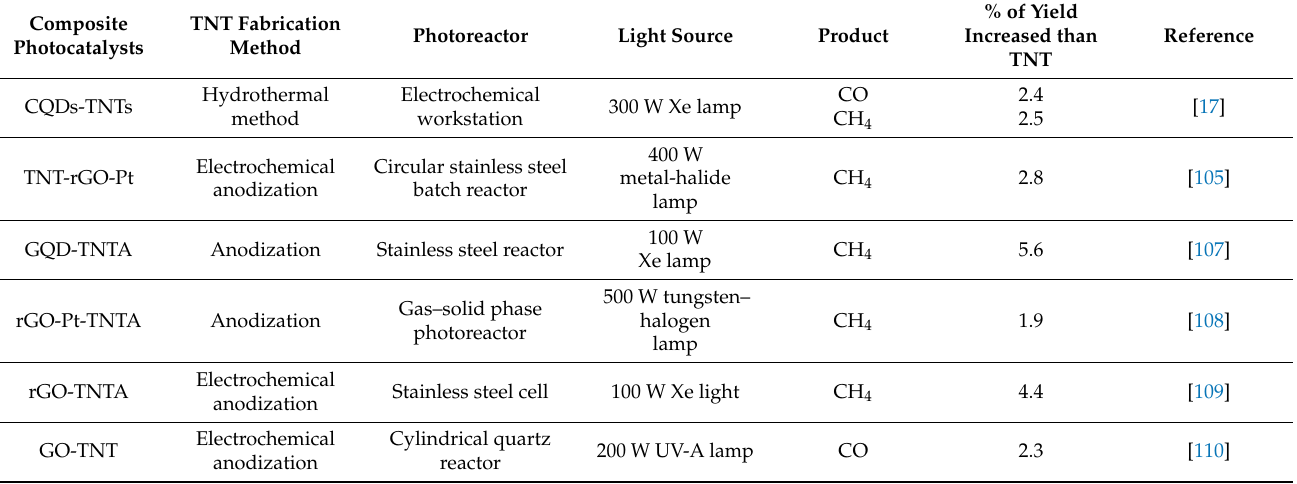
Table 4. Summary of carbon-based material-doped TNT photocatalysts used for CO 2